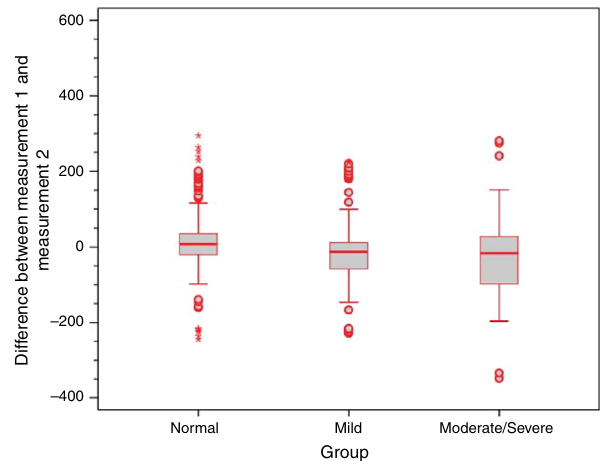
Figure 6 Box plot of differences between time points 1 and 2 for the Toynbee maneuver in the three study